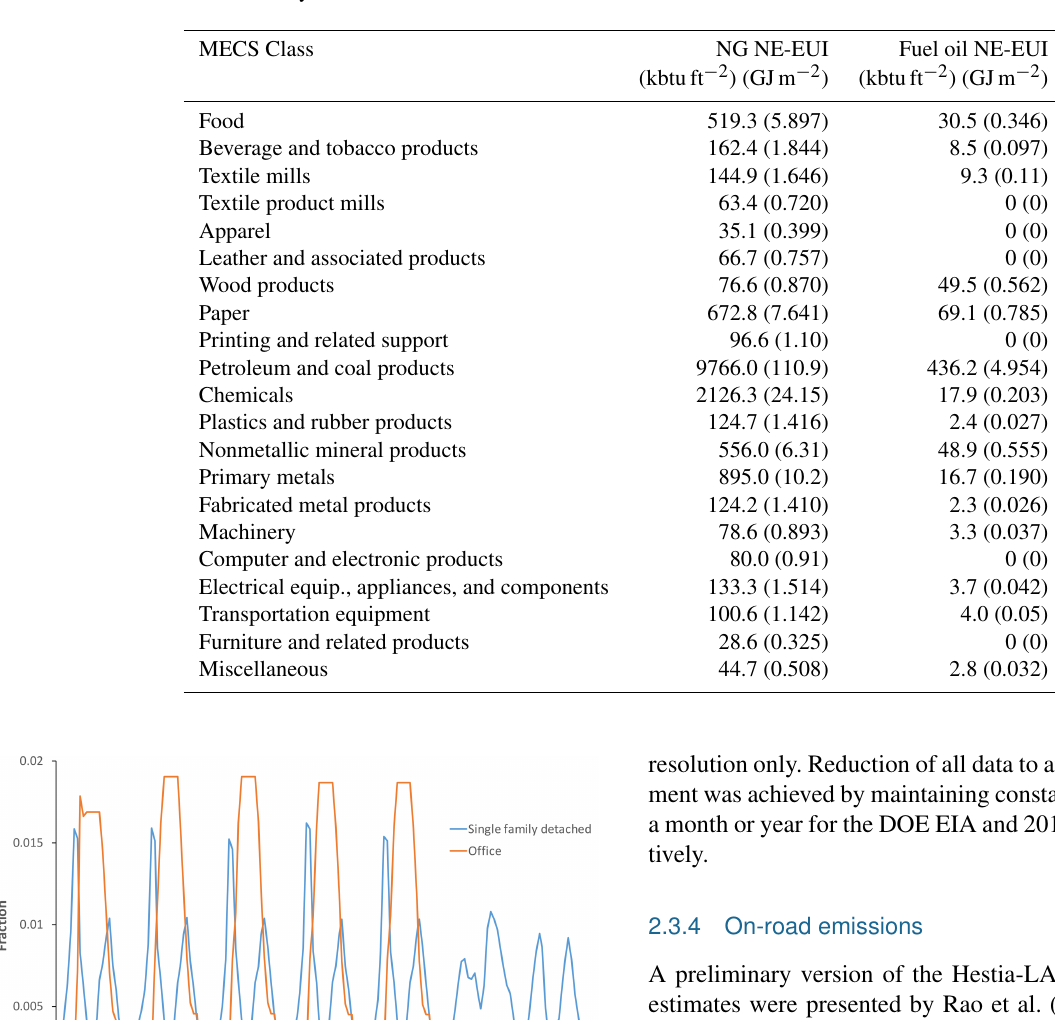
Table 4. Industrial NE-EUI survey values from the DOE EIA MECS database.